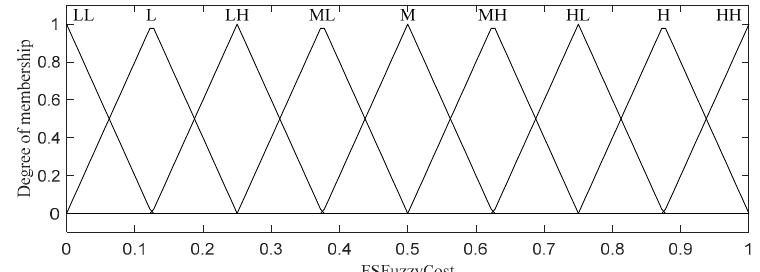
Figure 5. The fuzzy cost for feature selection; (LL = Low Low, L = Low, LH = Low High, ML = Medium